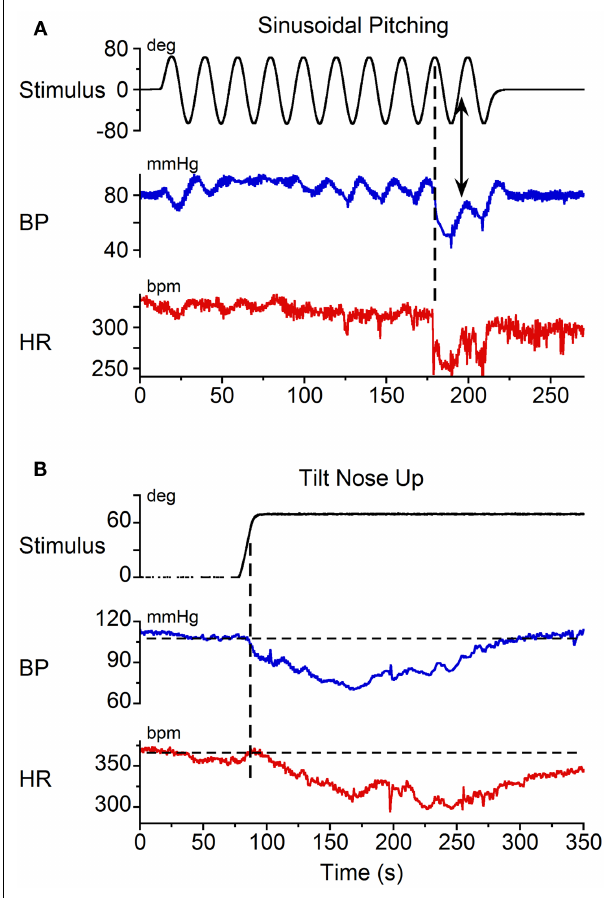
FIGURE 5 |Vasovagal responses induced by (A) sinusoidal pitching ± 70° at 0.025Hz and (B) static 70° nose-up body tilts . Black trace: stimulus; blue trace: BP; red trace: HR. (A) A vasovagal response was induced by sinusoidal pitching.The onset of the transient changes in BP and HR occurred when the animal was approximately 70° nose-up, as indicated by the vertical dashed line.The vasovagal response, which was initiated when the animal was nose-up, was terminated as the animal approached the prone position. (B) A vasovagal response induced by static nose-up tilt of 70°.